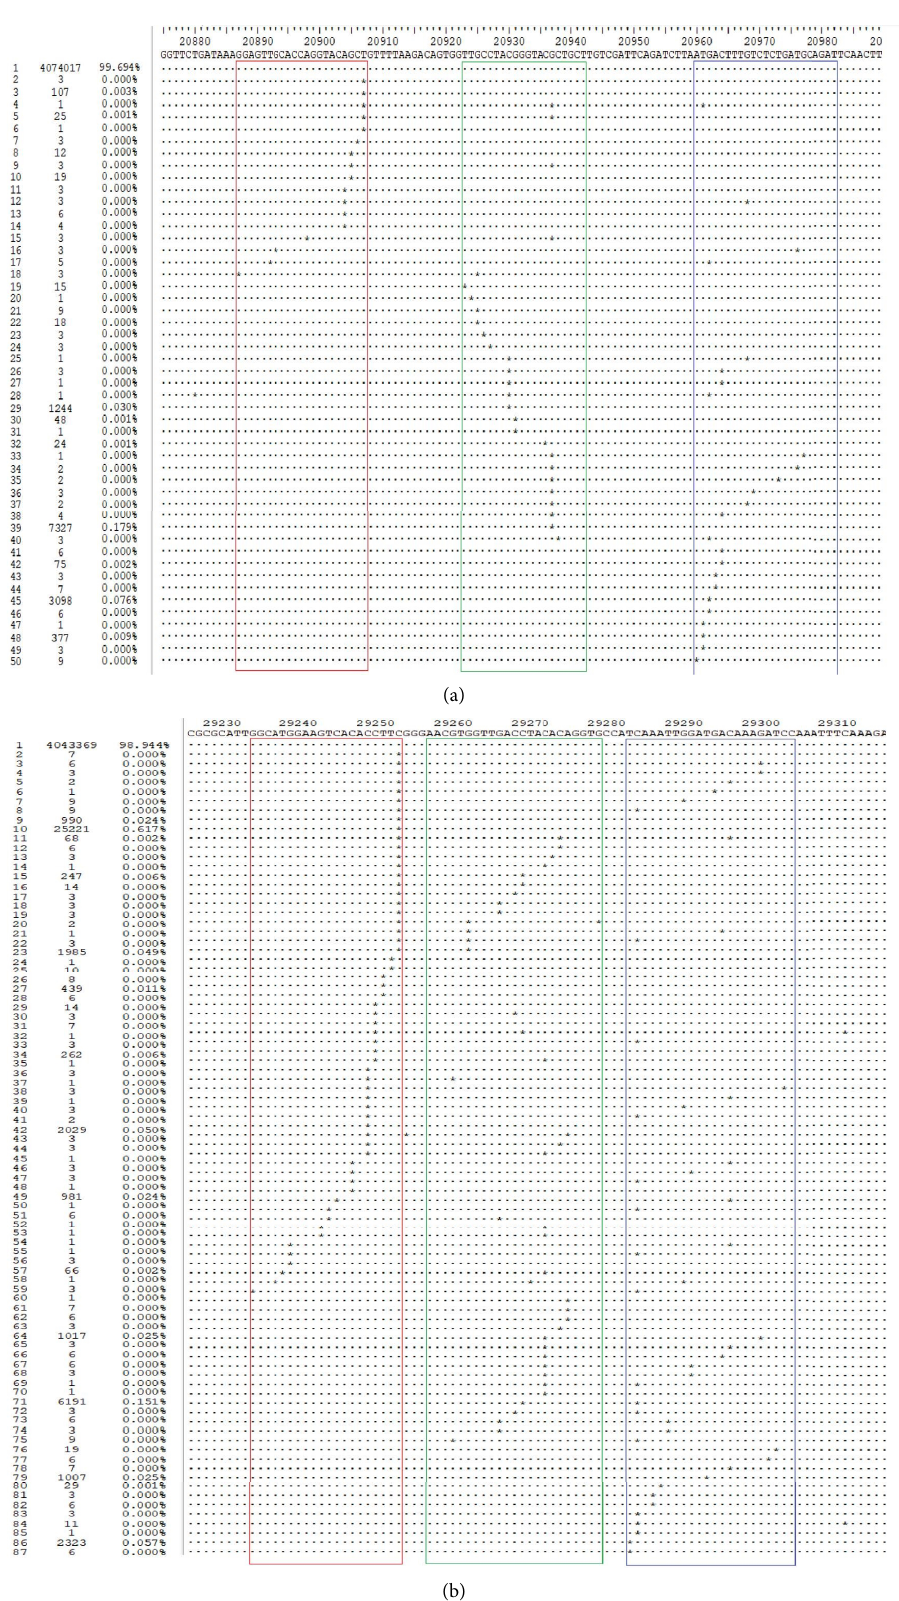
Figure 3: In-silico analysis of primer and probe of ORF1ab and N gene with SARS-CoV-2 sequence from GISAID database. (a) In-silico analysis result of primer and probe of ORF1ab. (b) In-silico analysis result of primer and probe of N gene. Te symbol. presents the consistent sequence, and ∗ presents the mismatch base pair. Te forward primer is marked by red box, probe marked by green box, and reverse primer marked by blue